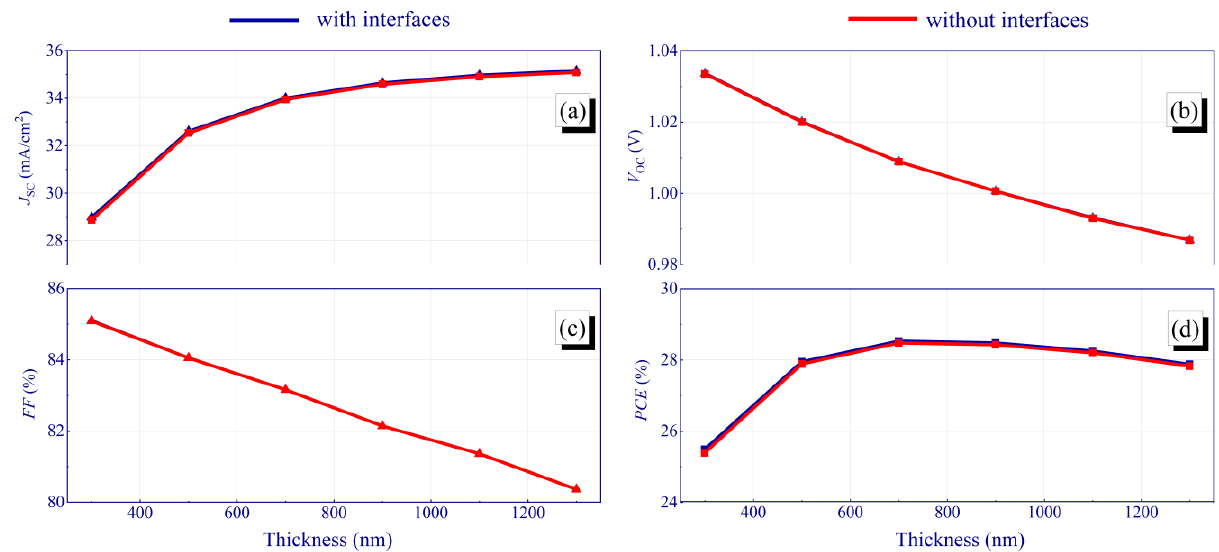
Figure 12. Influence of the perovskite absorbing layer thickness on J SC ( a ), V OC ( b ), FF ( c ), PCE ( d ).